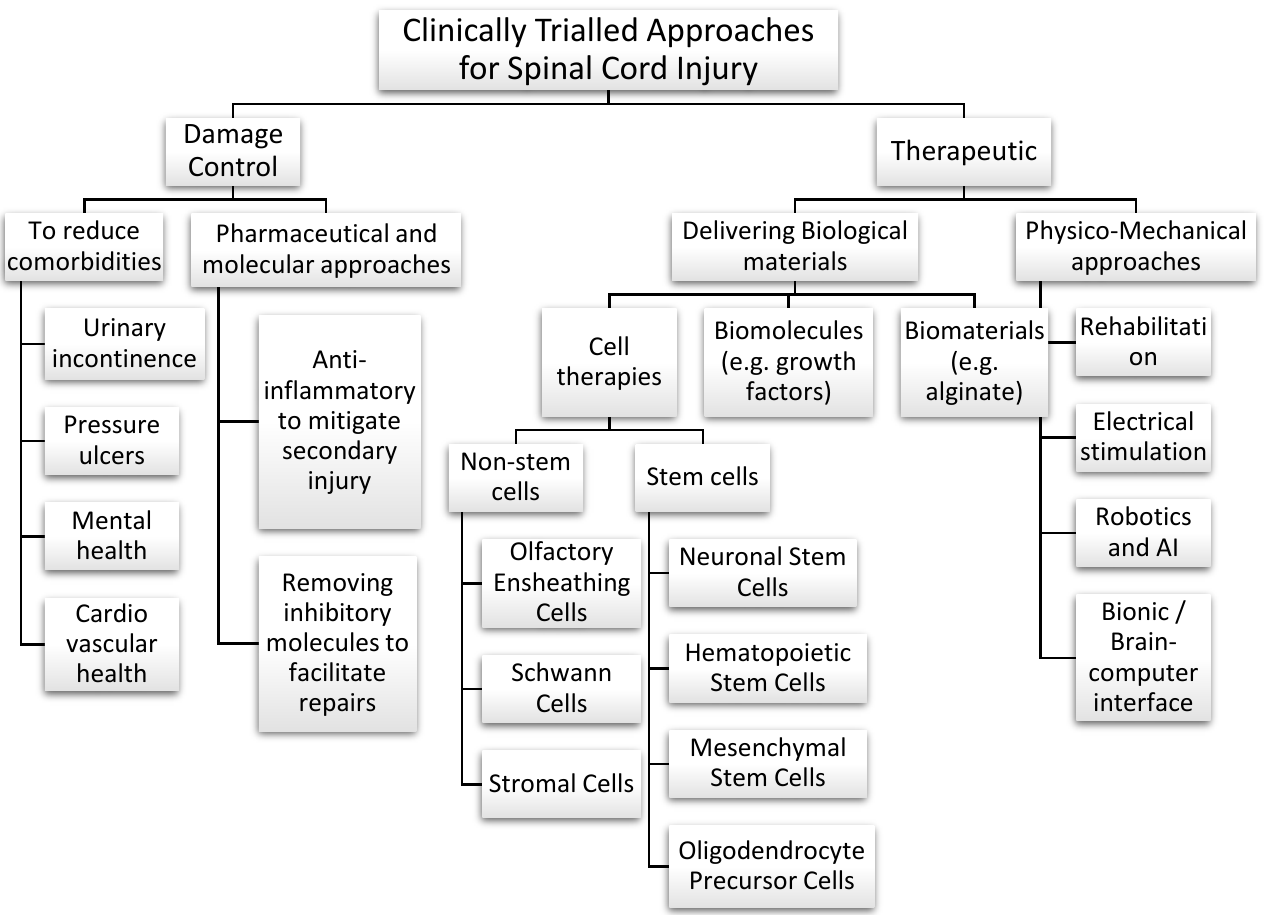
Figure 1. An overview of approaches under exploration for spinal cord injury treatment.